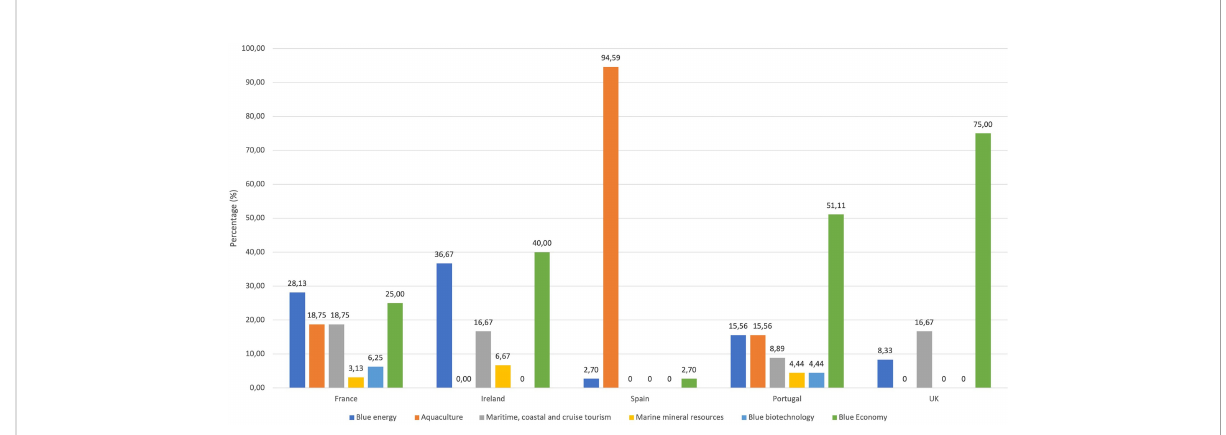
FIGURE 11 Percentage of measures of the fi ve National Ocean Strategies analyzed within the framework of the Blue Growth Strategy Focus Areas. Source: Created by the